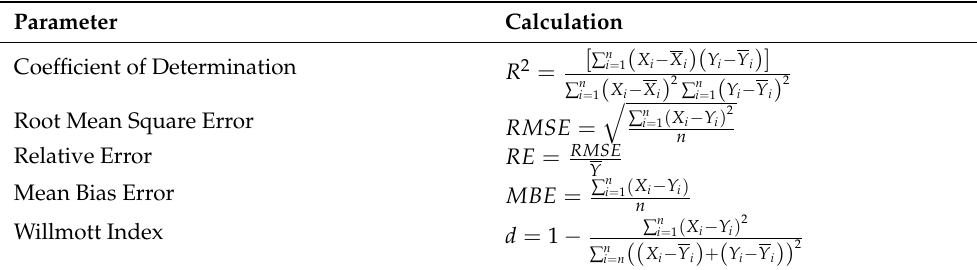
Table 4. Statistical parameters used to evaluate yield models from optical sensor measurements. R 2 and RMSE were used for calibration analyses. R 2 , RMSE , RE , MBE , and d , were used for validation analyses. X i , Y i , X i , and Y i represent sensor measurements, yield values, mean sensor measurements, and mean yield values, respectively, in the calibration stage. In the validation stage, X i , Y i , X i , and Y i represent observed yield, estimated yield, mean observed yield, and mean estimated yield. n is the number of